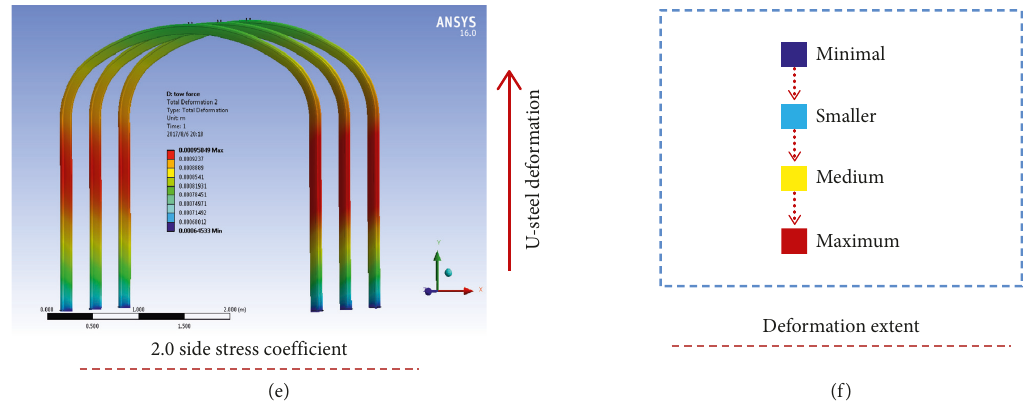
Figure 5: Deformation of the U-shaped steel with different lateral stress coefficients: (a) 0.8; (b) 1.0; (c) 1.2; (d) 1.5; (e) 2.0. Dark blue to deep red, small to large deformation. The maximum values were 1.3533mm, 1.2614 mm, 1.1701 mm, 1.0344mm, and 0.95849 mm, respectively.